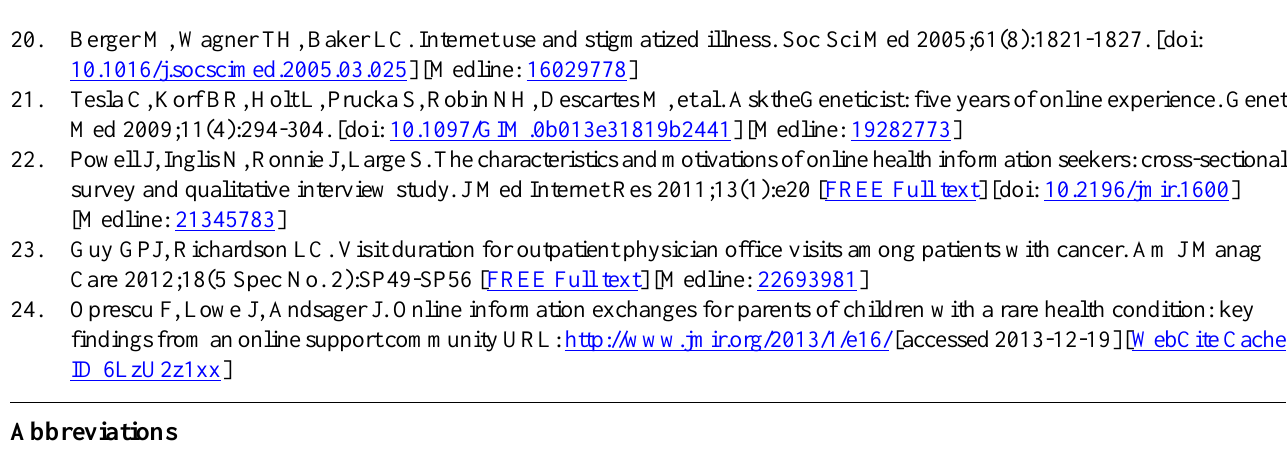
GARD: Genetic and Rare